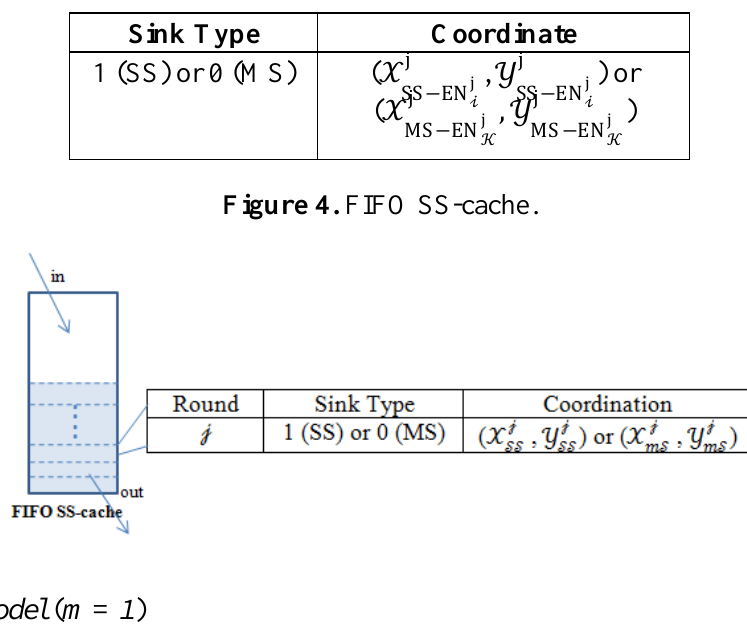
Table 2. Response (queuing) message.